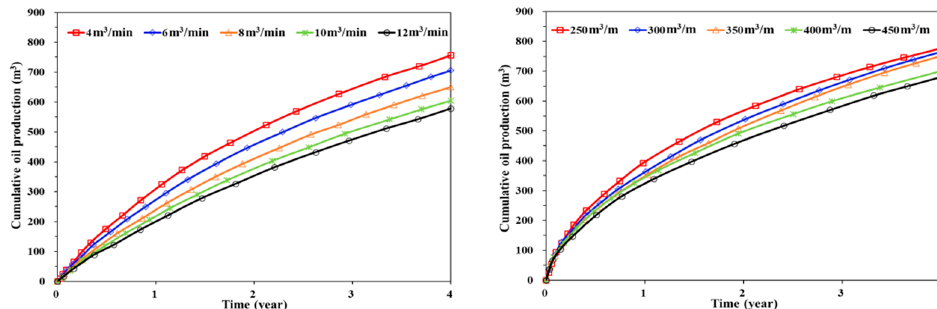
Figure 23. Injection rate and liquid injection intensity sensitivity.